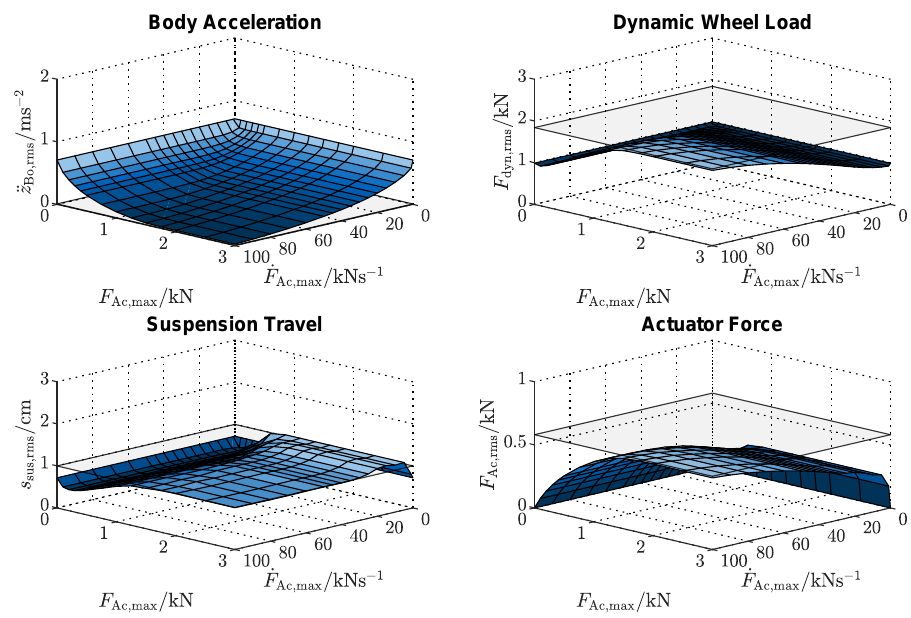
Figure 10. RMS surface plots for the 90kmh − 1 AB profile scenario.